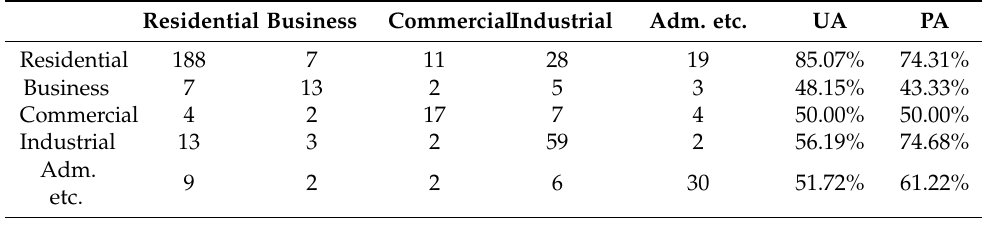
Table 8. Parcel confusion matrix for Level II (4000 training & 445 testing samples).